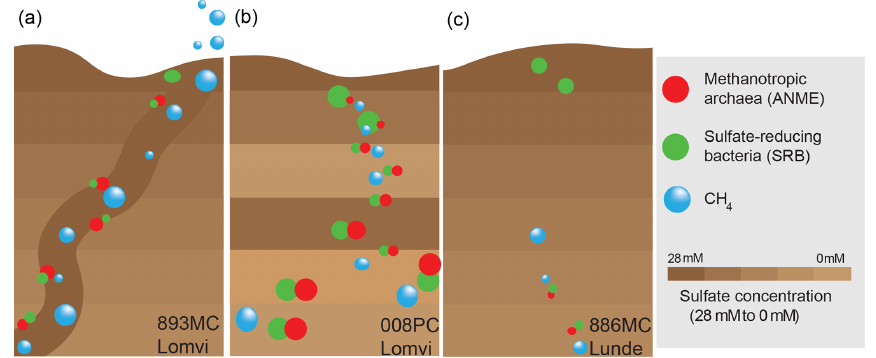
Figure 6. Schematic illustration of different methane transport modes in the study area (big bubble and circle sizes highlight high methane concentrations and the approximate size of the standing stocks of AOM communities, respectively). Low amounts of methane in a diffusion- dominated setting sustain a weakly defined AOM microbial community (c) . Mini-fracturing enhances the methane availability and fosters AOM community growth (a) . The AOM community is fully developed after advective methane transport has continued for a longer period of time (b)